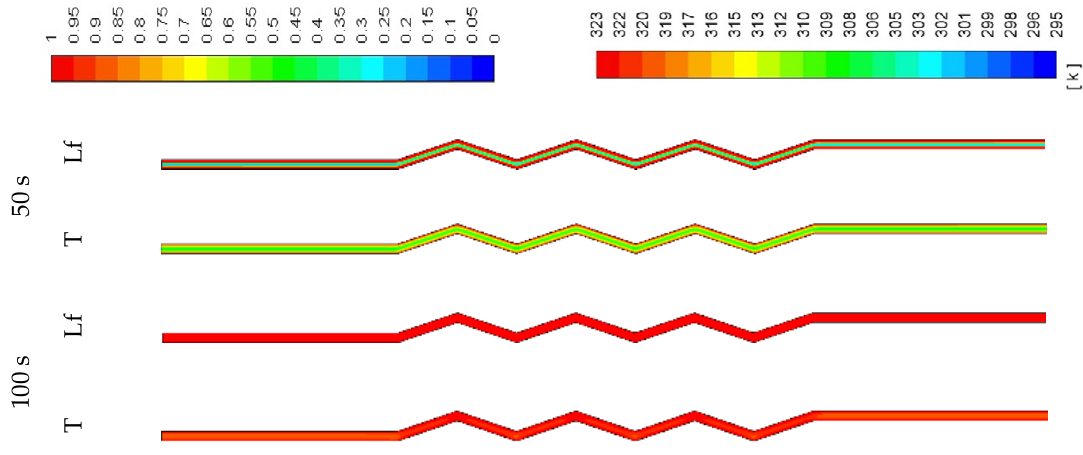
Figure 17. Contours of the liquid-fraction and temperature in the melting process for the half-width (0.5 W) horizontal corrugated channel.